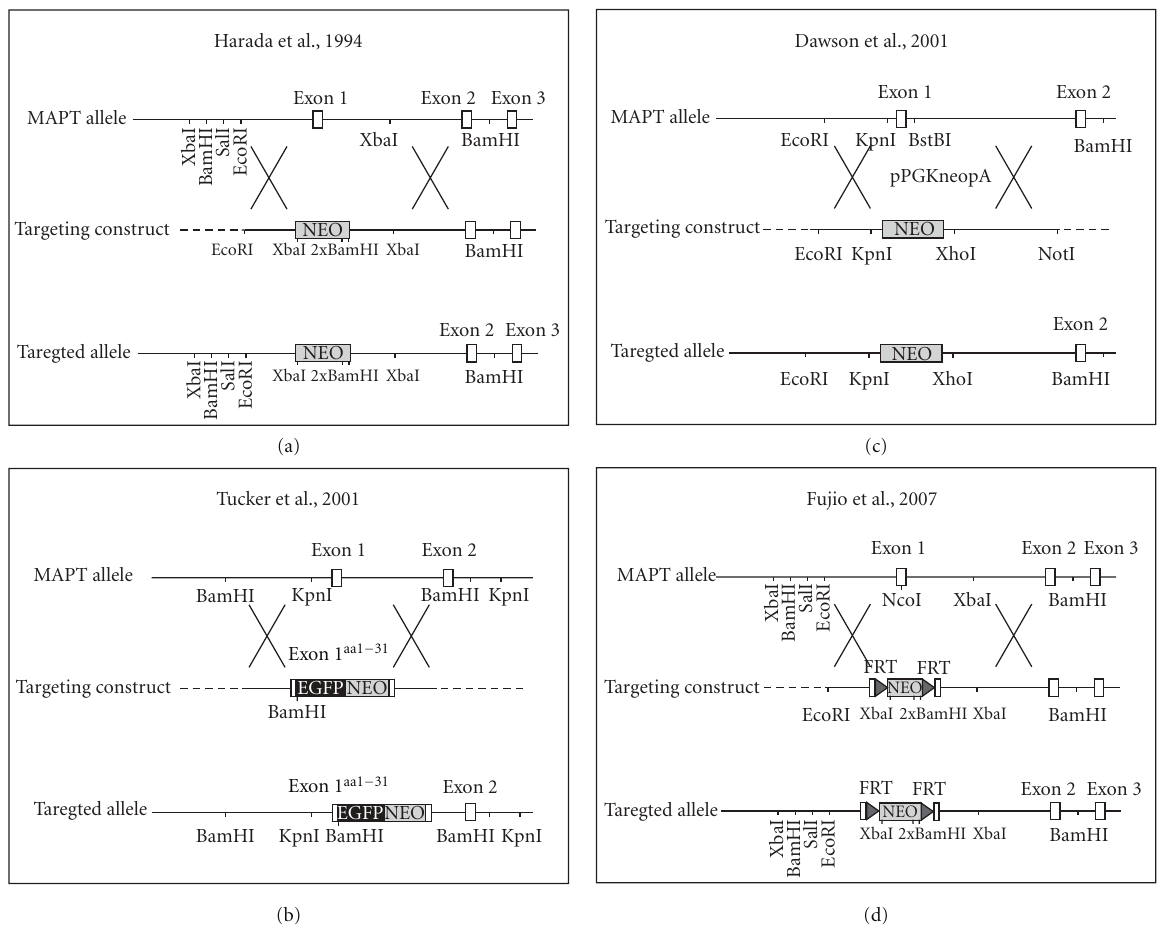
Figure 1: Homologous recombination strategies for the generation of di ff erent tau knockout mice reported by (a) Harada and collegues [39], (b) Tucker and colleagues [41], (c) Dawson and colleagues [40], and (d) Fujio and colleagues